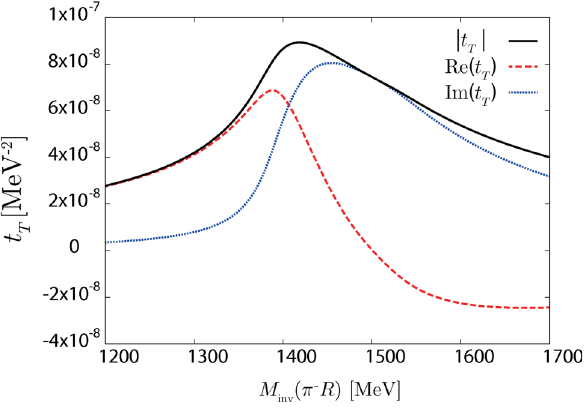
Fig. 5 The derivative of the mass distribution of B − → D ∗ 0 π − π 0 η with regards to M inv ( a 0 )